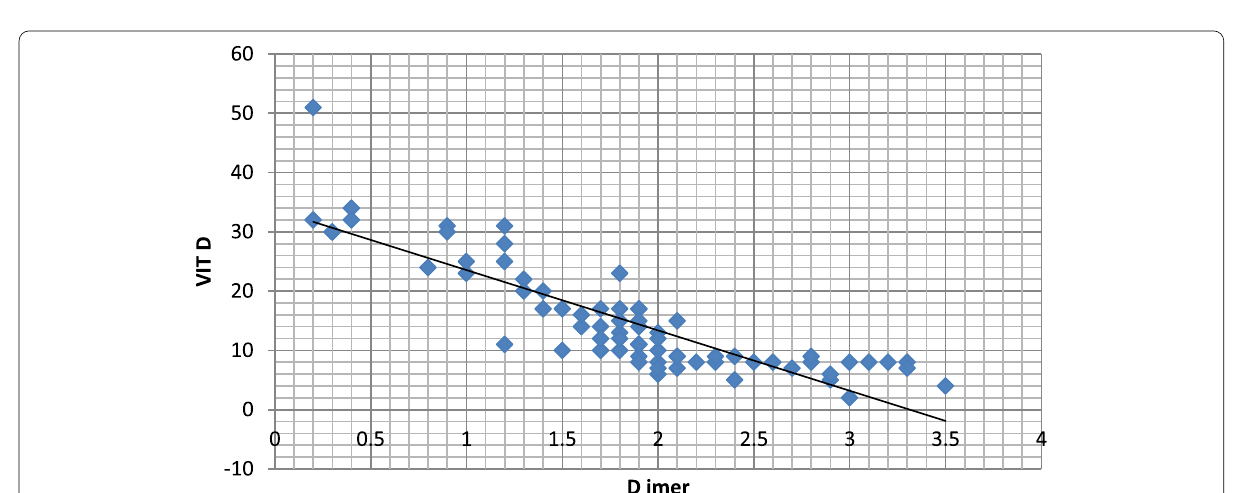
Fig. 25 Correlation between vitamin D and D-dimer